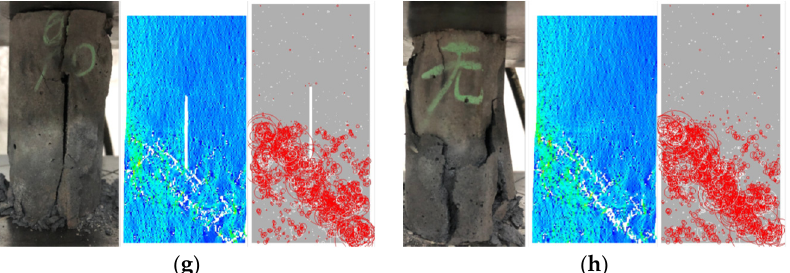
Figure 12. Failure modes of coal–rock combination body with different prefabricated crack angles: ( a ) θ = 0°; ( b ) θ = 15°; ( c ) θ = 30°; ( d ) θ = 45°; ( e ) θ = 60°; ( f ) θ = 75°; ( g ) θ = 90°; ( h ) intact specimen.